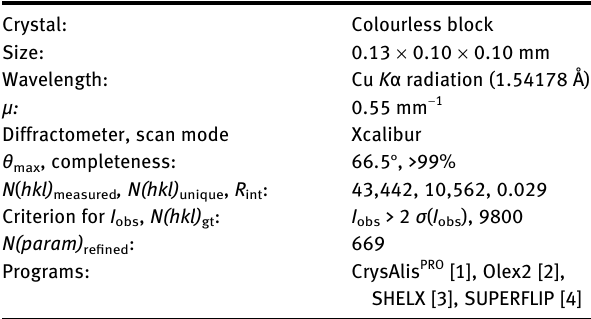
Table  : Data collection and